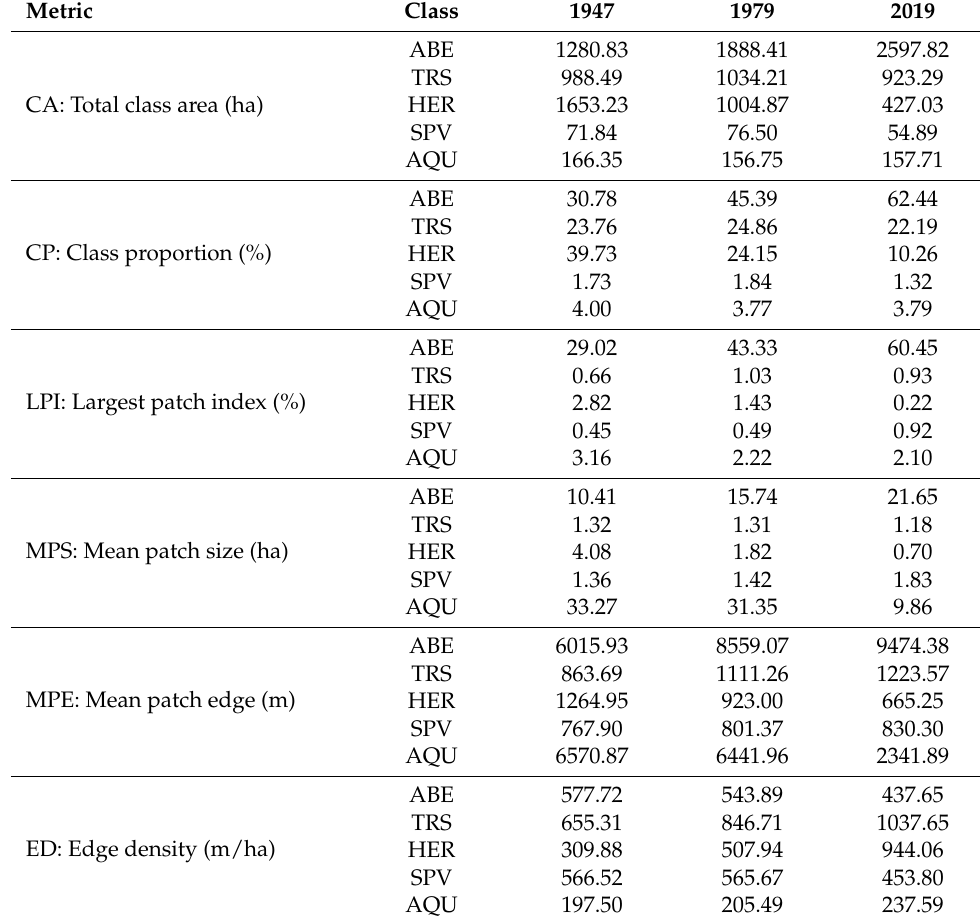
Table A2. Area and edge metrics at the class level, for 1947, 1979, and